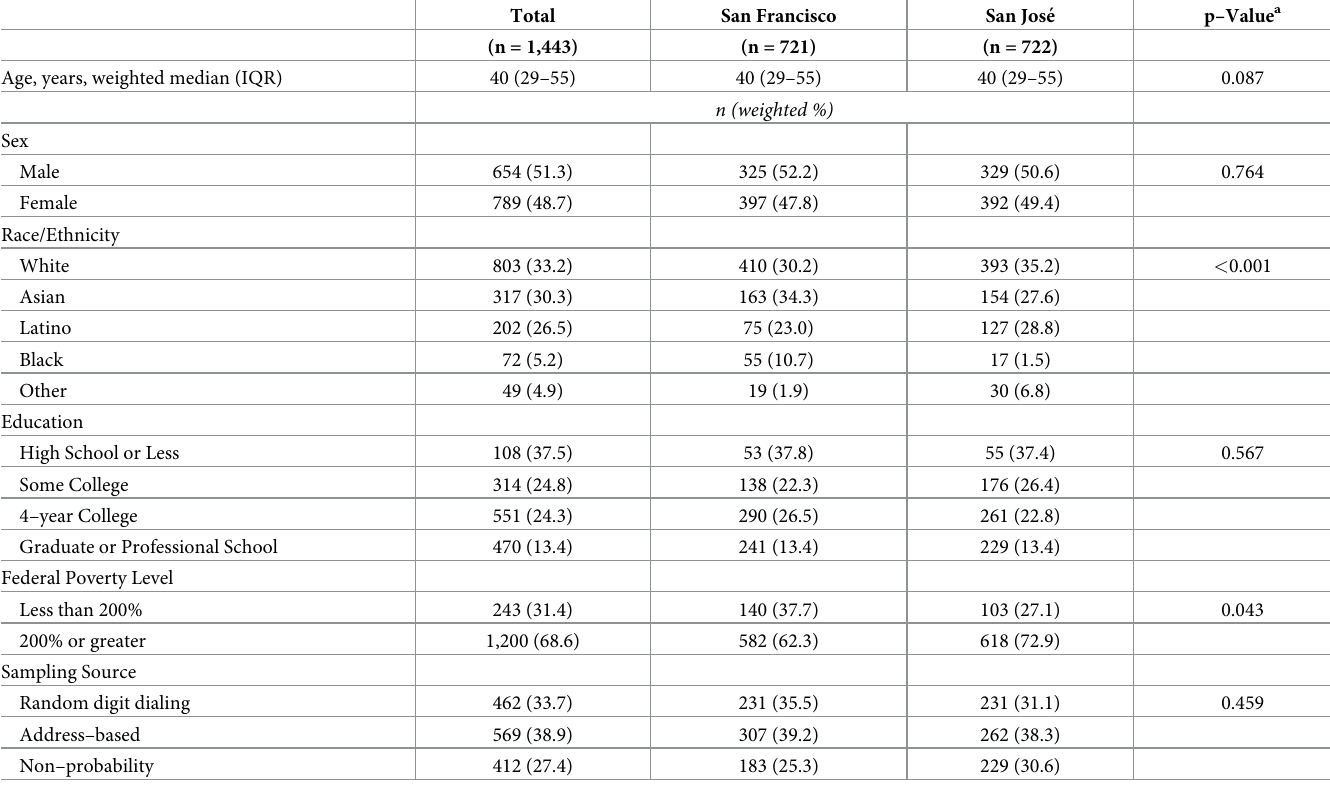
Table 1. Characteristics of sample at baseline, overall and by city